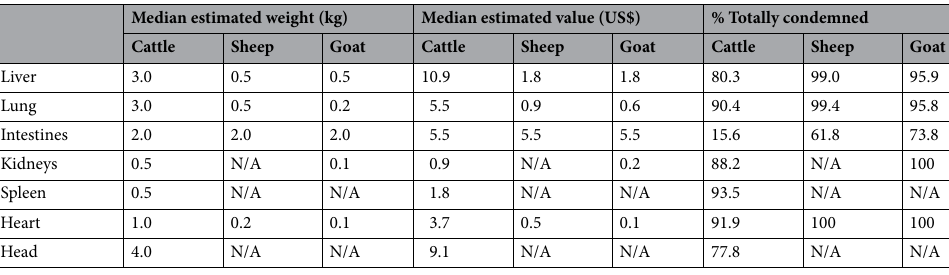
Table 3. The median estimated weight (kg) and non-condemned market value (US$) of each condemned organ, and the proportion that were totally (versus partially) condemned, for each animal species, in two slaughterhouses in Bungoma County, western Kenya, between 17th March 2017 and 31st December 2019.